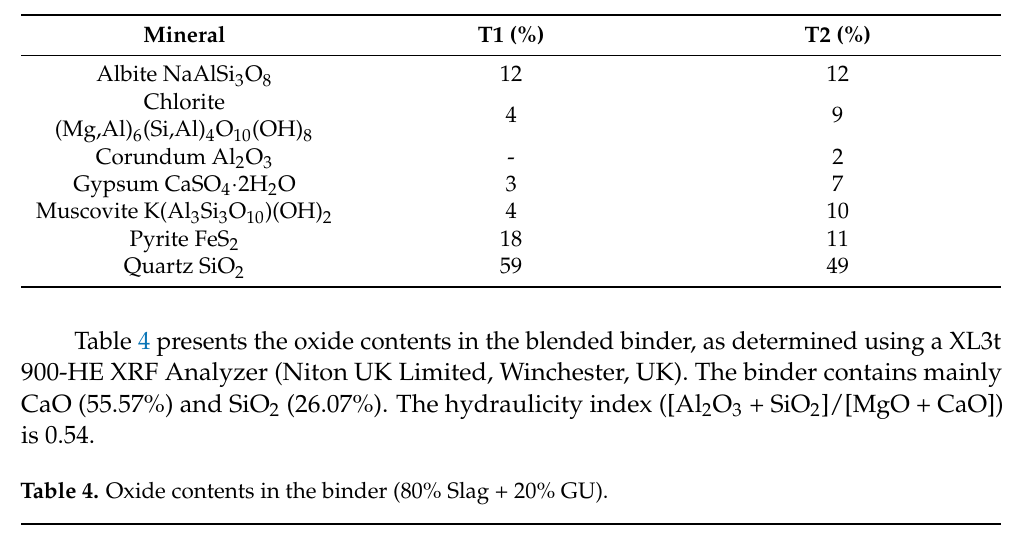
Table 3. Mineralogical composition of the tested tailings.